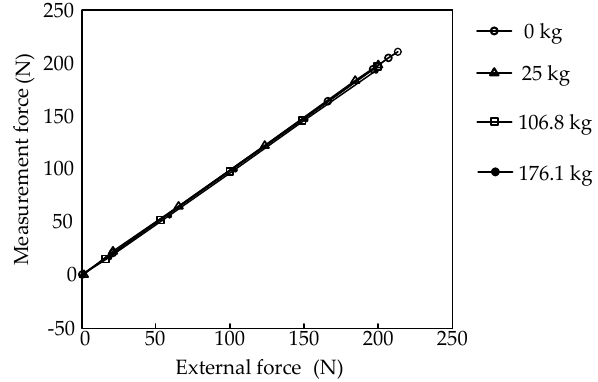
Figure 10. Force diagram with consideration of friction.